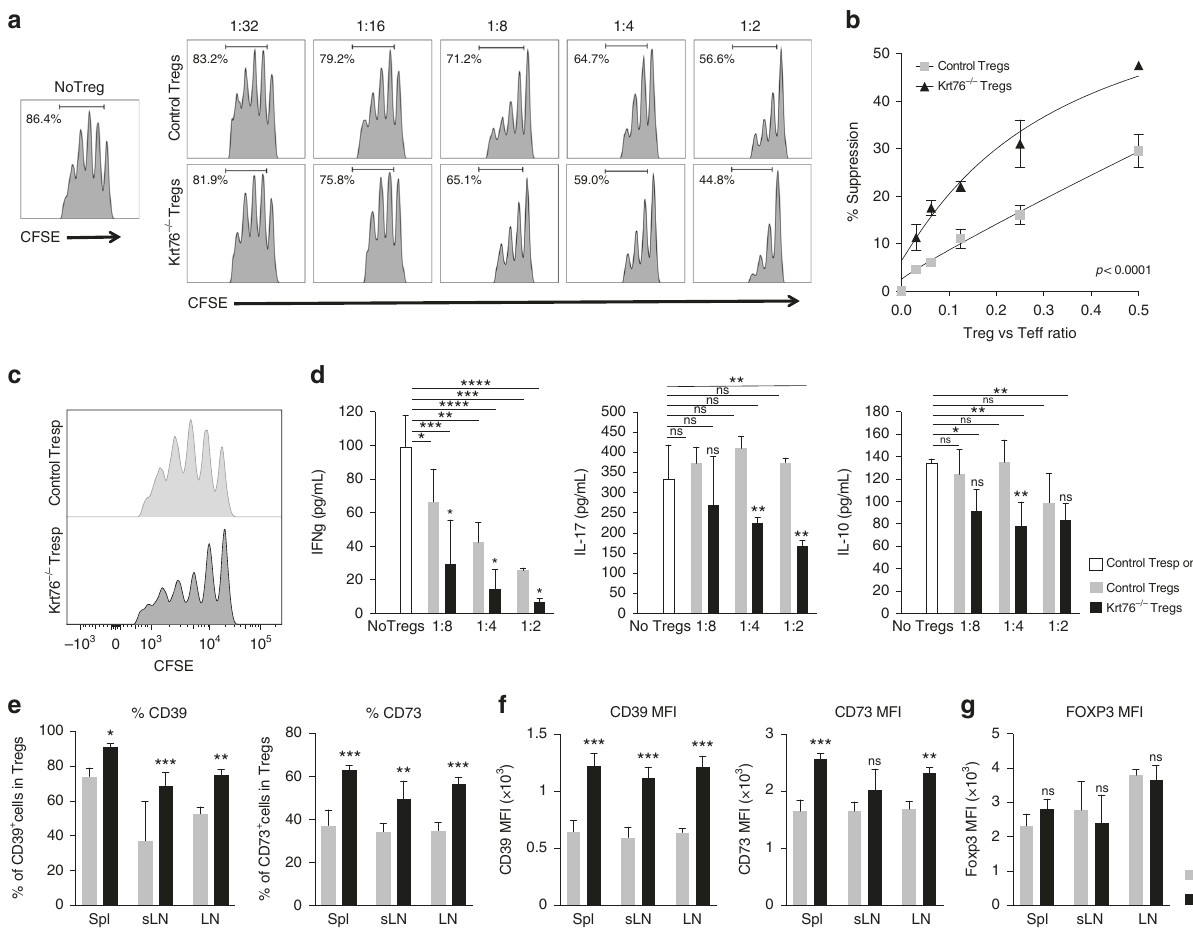
Fig. 4 Phenotype and suppressive function of Krt76 − / − Tregs. a Representative plots from a suppression assay involving different ratios of Tresp to Treg, showing CFSE pro fi le quanti fi ed by fl ow cytometry after gating on CD4 + cells. This illustrates dose-dependent suppression of wild-type CD4 + CD25 - Tresp proliferation in the presence of control or Krt76 − / − Tregs. b Cumulative data showing % control Tresp suppression at each Tresp:Treg ratio in the presence of control or Krt76 − / − Tregs. Mean ± s.e.m, two independent experiments, 2-way ANOVA, p < 0.0001, Non-linear regression (curve fi t) of Treg suppression. c Representative plots of Tresp CFSE pro fi les after gating on CD4 + cells, illustrating proliferation of Tresp from Krt76 − / − and control mice in the absence of Tregs. d Levels of cytokines in cell culture medium for each Tresp:Treg ratio, assessed by CBA analysis (means ± s.e.m., multiple t -tests and two-way ANOVA, each culture condition in triplicate, measured in duplicate, experiment repeated twice). e Summary of fl ow cytometric analysis of % CD39 + and CD73 + Tregs from total Tregs (CD4 + CD25 + Foxp3 + ) in spleen (Spl), lymph nodes (LN) and submandibular LN (sLN) from control and Krt76 − / − mice. f, g Maximum intensity fl uorescence (MFI) of CD39, CD73 ( f ) and Foxp3 ( g ) expression in CD4 + CD25 + Foxp3 + Tregs ( n = 4